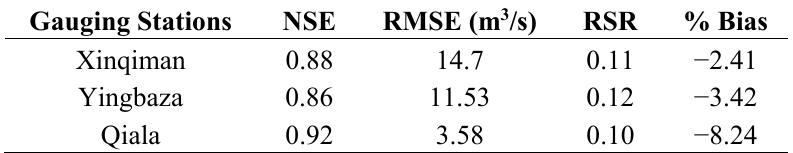
Table 4. Evaluation of calibration performance for three gauging stations: